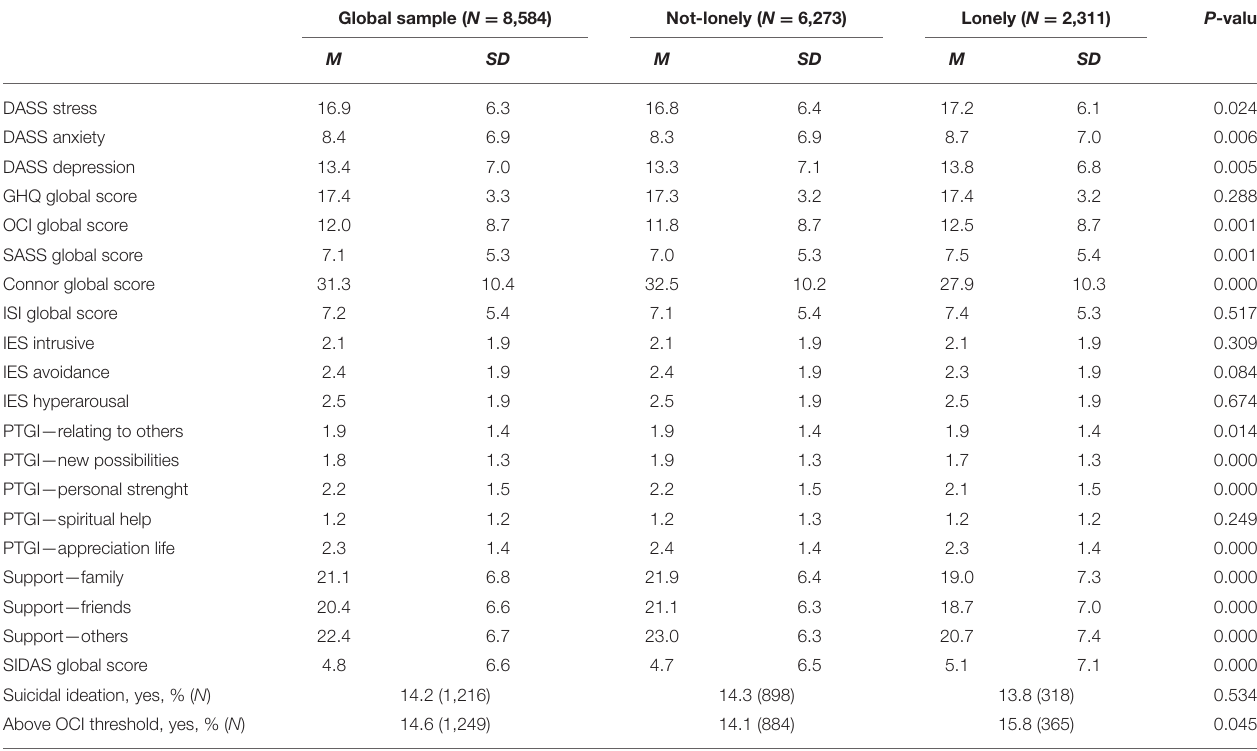
TABLE 2 | Differences in clinical features between lonely and not-lonely participants. Global sample ( N = 8,584) Not-lonely ( N = 6,273) Lonely ( N = 2,311) P